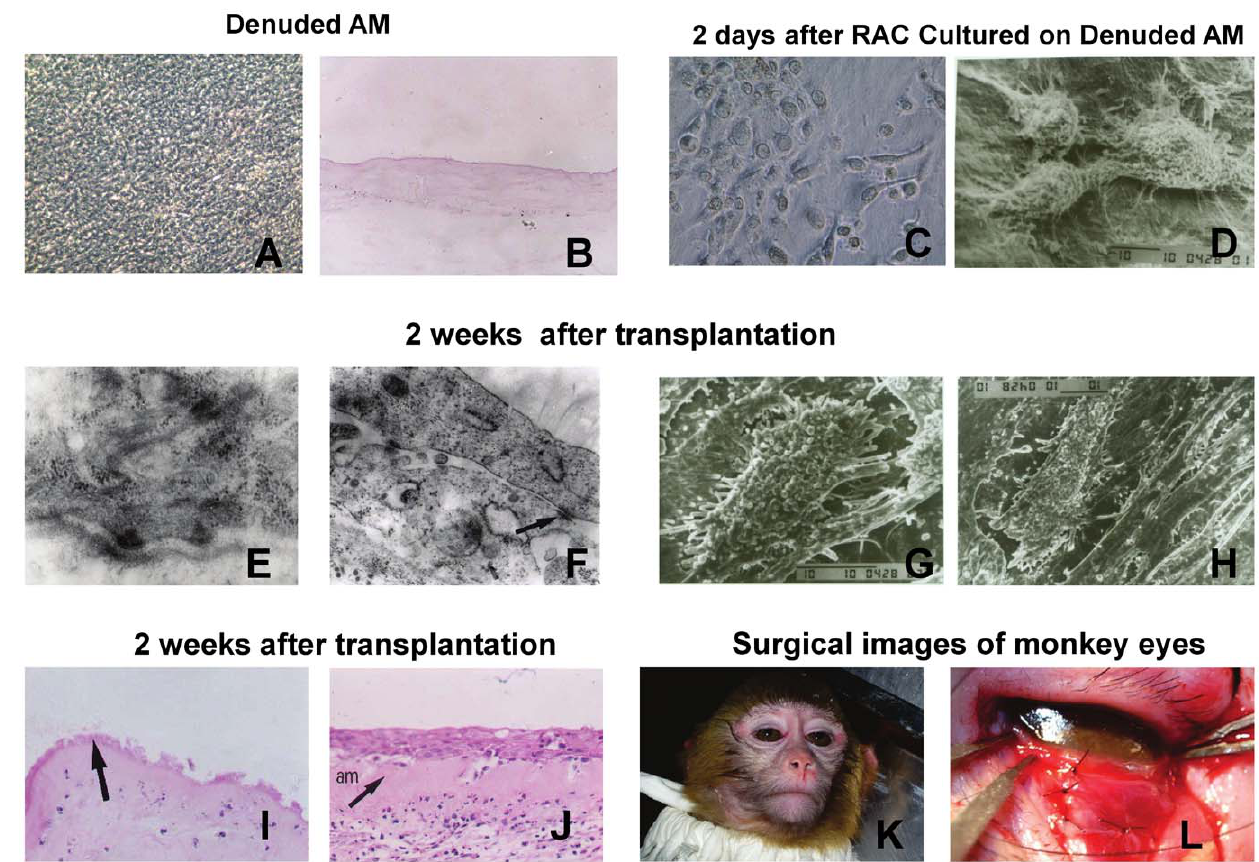
Figure 3. Cultivation of epidermal progenitor cell-derived sheets on denuded AM and autologous transplanted to ocular surface. A and B. Images of Denuded AM. A. Representative phase image ( 6 100); B. Hematoxylin and eosin staining image ( 6 100); C and D. Representative images of epidermal progenitor cells cultured on denuded AM at 2 days. C. Representative phase image showing epidermal progenitor cells form colonies on AM within 48 hours ( 6 400); D. Scanning electron microscopy photography showing epidermal progenitor cells adhered tightly with AM ( 6 2000); E to H. Electron microscopy photography of progenitor cell-derived epidermal sheets at 2 week after transplantation. E. TEM photography showed hemidesmosomes between basal cells and AM ( 6 15000); F. Adjacent cells were joined with numerous desmosomal junctions ( 6 13000); G and H. SEM photography showed the cells appeared to be in good condition and were closely attached to each other with tightly fitting cell junctions ( 6 3500); I. HE staining image of transplanted preserved AM in controls, which showed discontinuous monolayler epithelium, and no nuclei found in the epithelial cells ( 6 200); J. HE staining image of autologous transplantation of progenitor cell-derived epidermal sheets, which showed several layers of healthy epithelial cells on AM ( 6 200); K and L. Surgical images of monkey